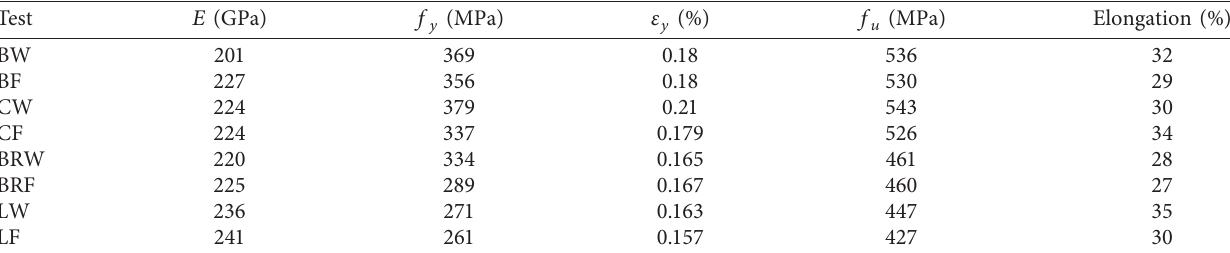
Figure 3: Details of the connections (mm). (a) Detailing of bolted connections. (b) Link connection. (c) Brace connection. (d) End plate of link. (e) Ribbed plate of link. Table 3: Test results of the steel material properties.